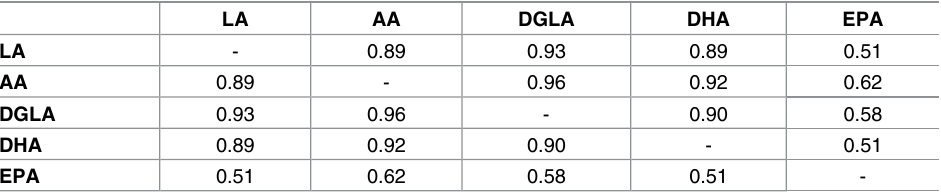
EPA 0.51 0.62 0.58 0.51 - All pairwise comparisons p < 0.001. AA- arachidonic acid, DGLA- dihomo- γ -linoleic acid, DHA- docosahexaenoic acid, EPA-